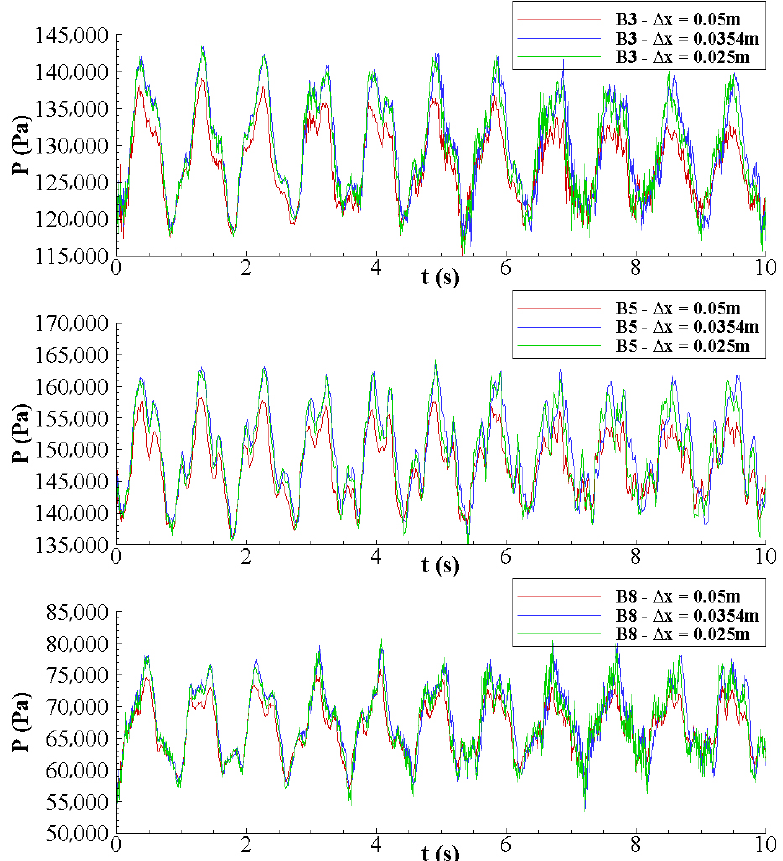
Figure 11. Comparison of the influence of different particle sizes on the boundary pressure evolu- tion at three boundary points.